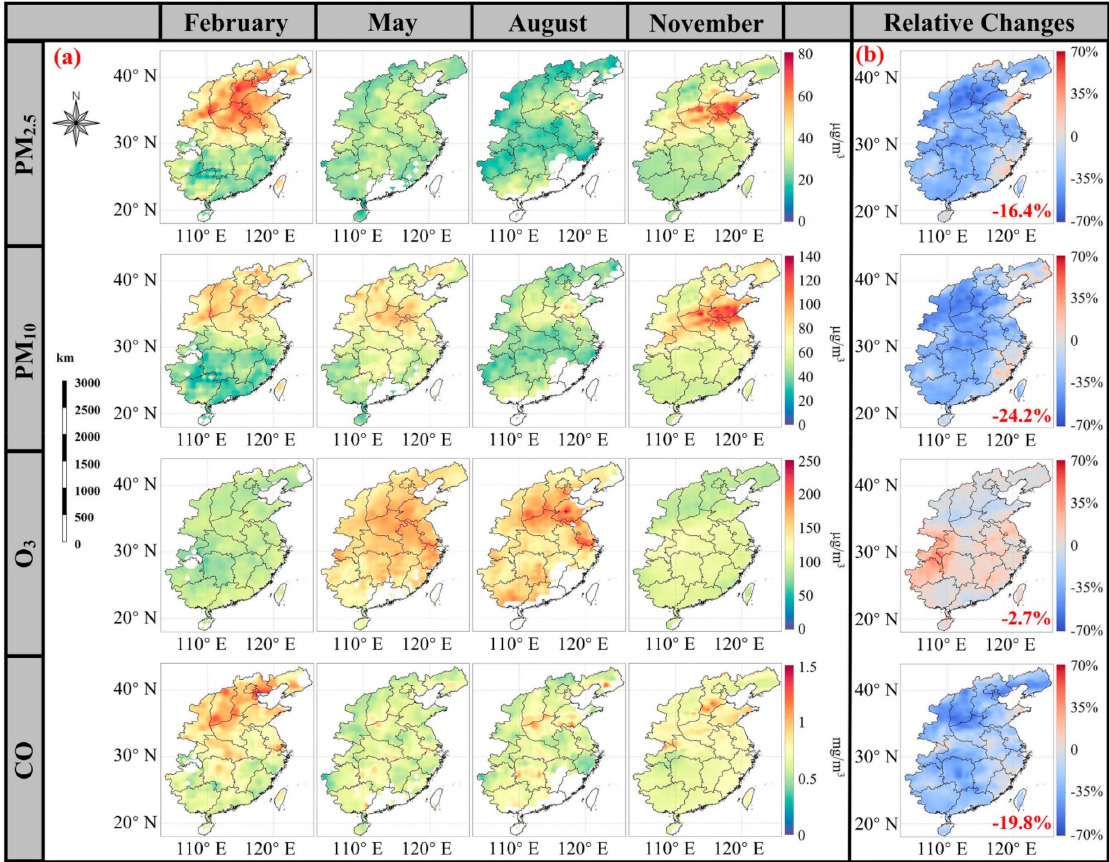
Figure 6. Spatial distributions of model-predicted PM 2.5 , PM 10 , O 3 , and CO concentrations in February, May, August, and November 2020 and their relative annual rates of change. ( a ) Spatial distributions of PM 2.5 , PM 10 , O 3 , and CO, respectively; ( b ) Relative annual average changes in PM 2.5 , PM 10 , O 3 , and CO concentrations, respectively. White area indicates no